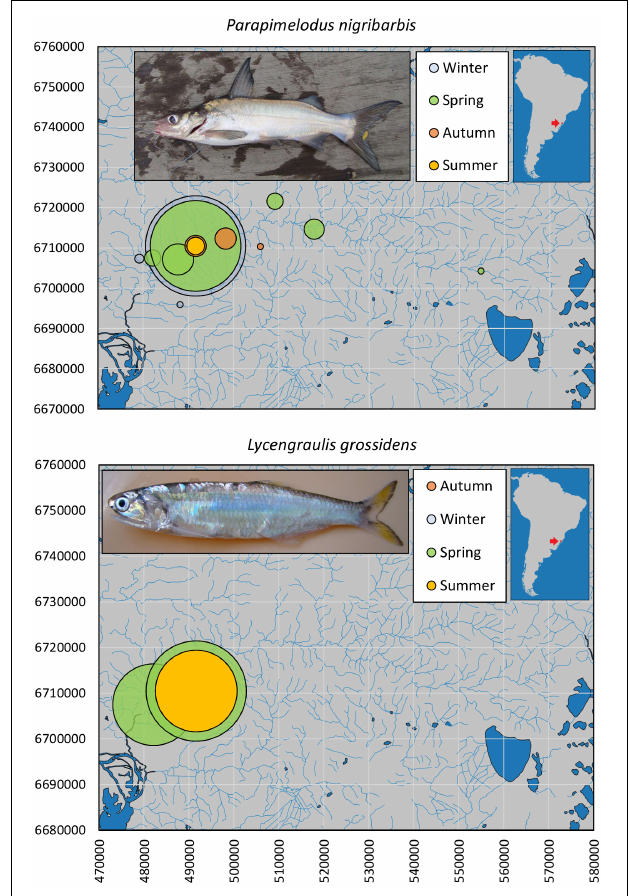
FIGURE 2 | Spatial and seasonal relative abundances of Parapimelodus nigribarbis ( n = 459) and Lycengraulis grossidens ( n = 7) in the Sinos River basin, southern Brazil. Bubble area proportional to number of captures per site. Fish photographs from Timm, C.D. available at Fishbase.com. Vector map background from FEPAM open database (http://www.fepam.rs.gov.br/biblioteca/geo/bases_geo.asp). 22J UTM